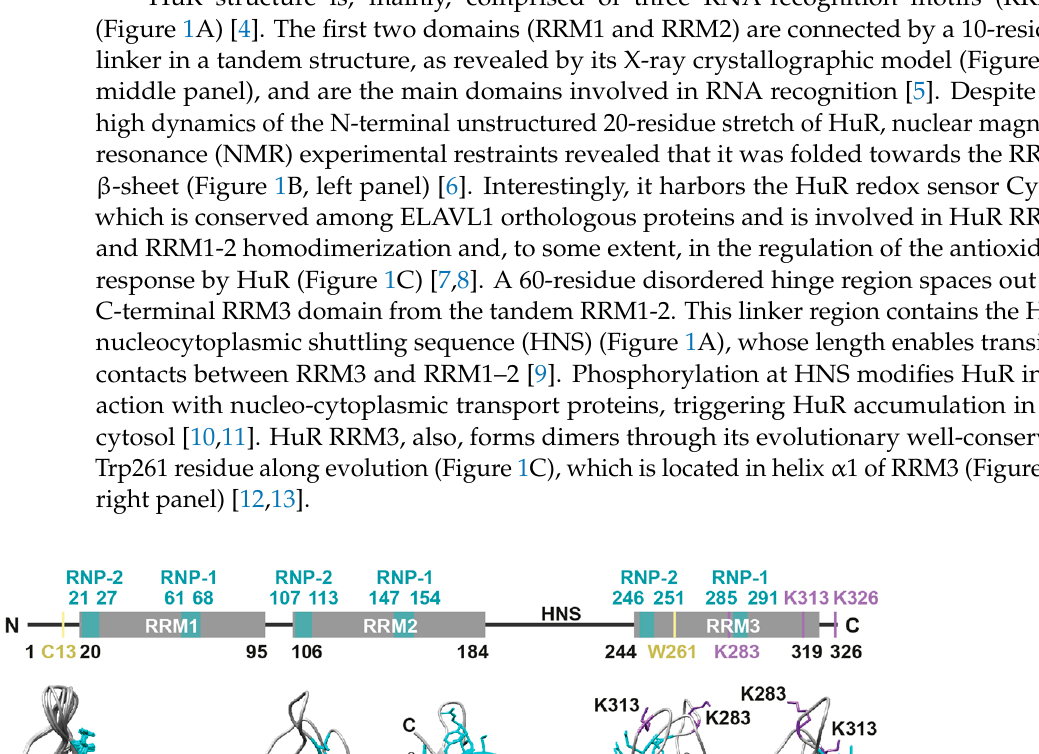
Figure 1. HuR domain organization, structures, and sequence alignment. ( A ) Schematic domain or- ganization of human HuR. Black numbers indicate the residues flanking each domain. RNPs and